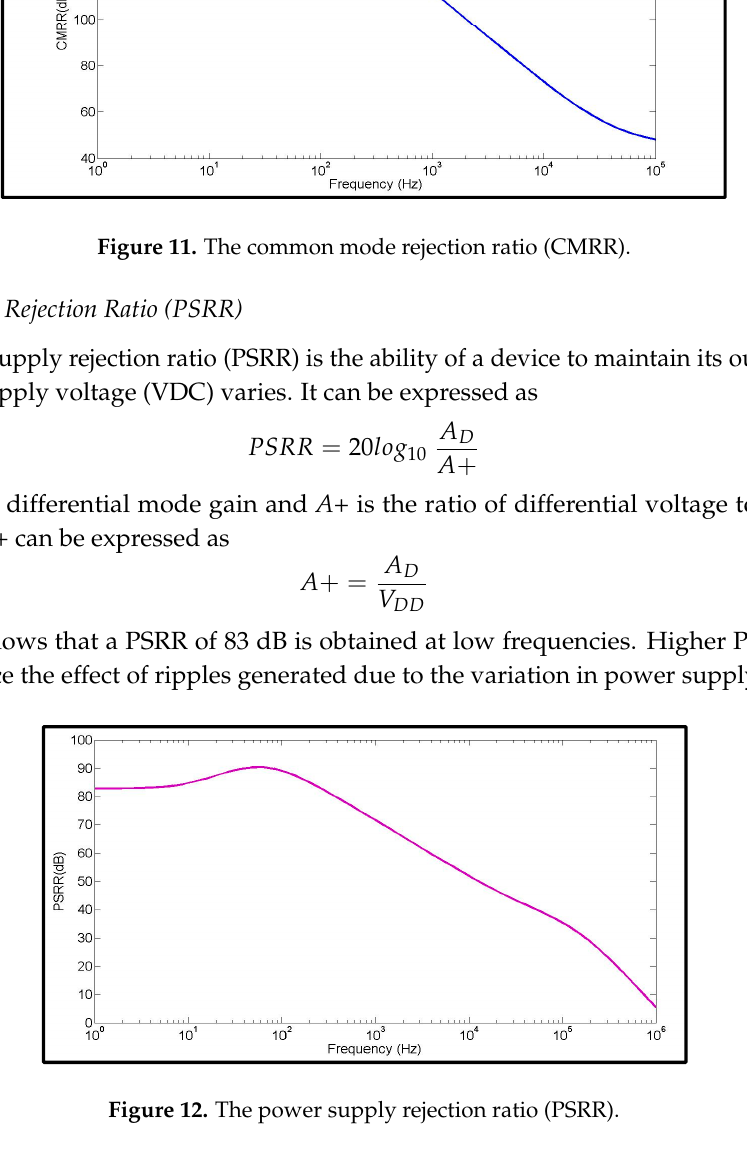
Figure 12. The power supply rejection ratio (PSRR).